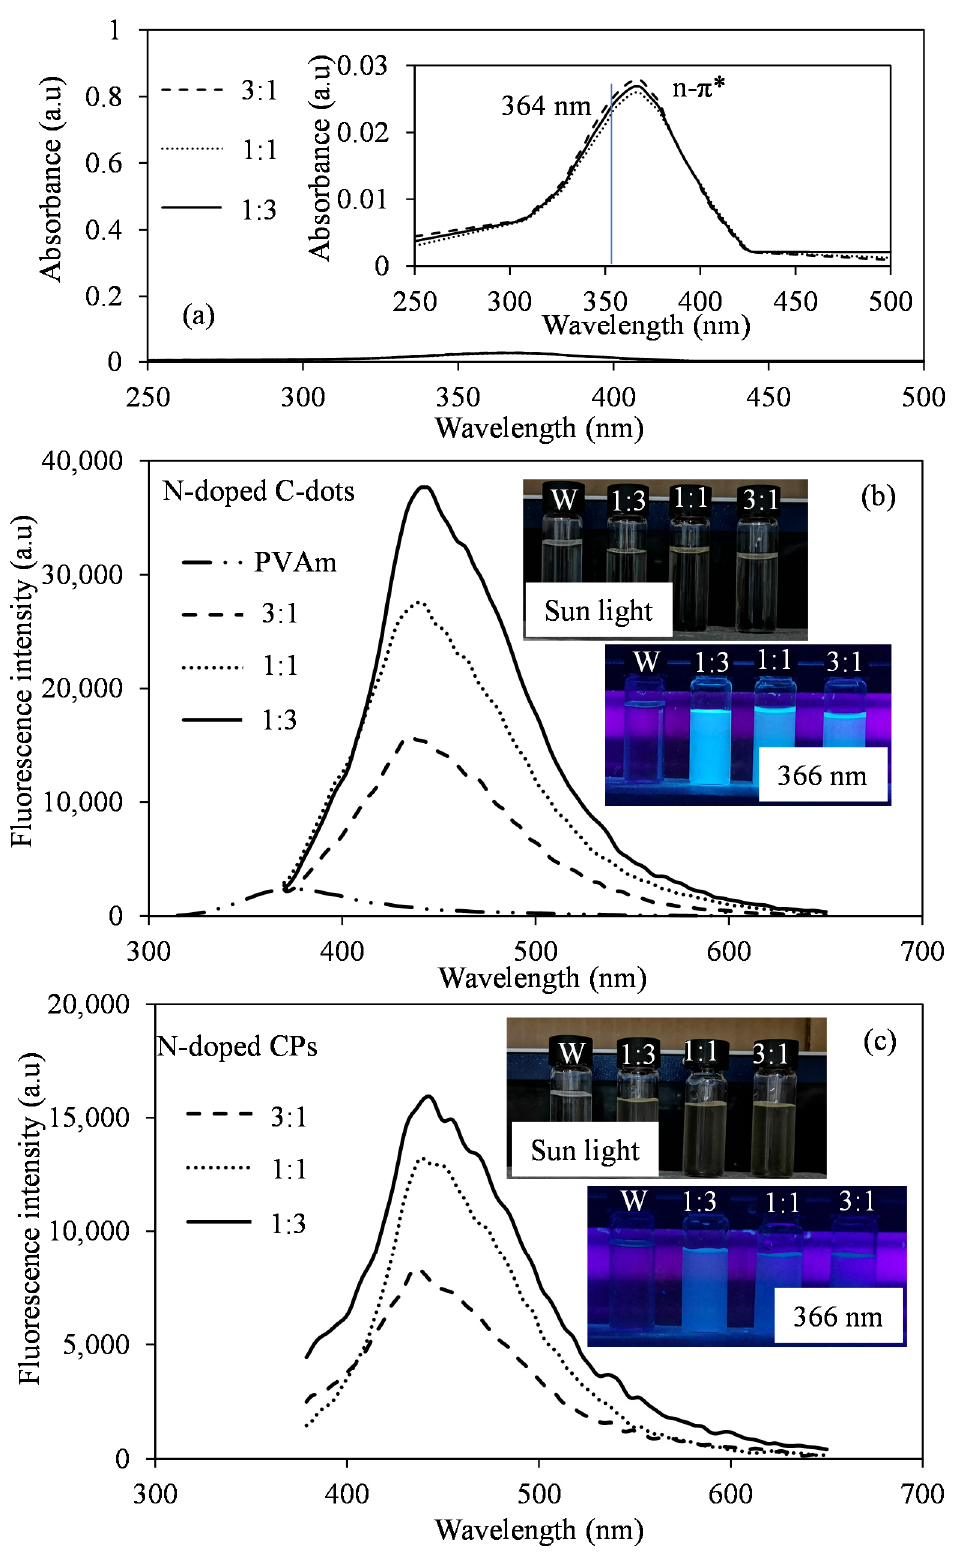
Figure 4. ( a )The UV–Vis spectra of N-doped C-dots, and fluorescence emission spectra of ( b ) N-doped C-dots (inset: their corresponding digital photograph images under the sunlight and 366 nm UV light) and ( c ) N-doped CPs (inset: their corresponding digital photograph images under the sunlight and 366 nm UV light).